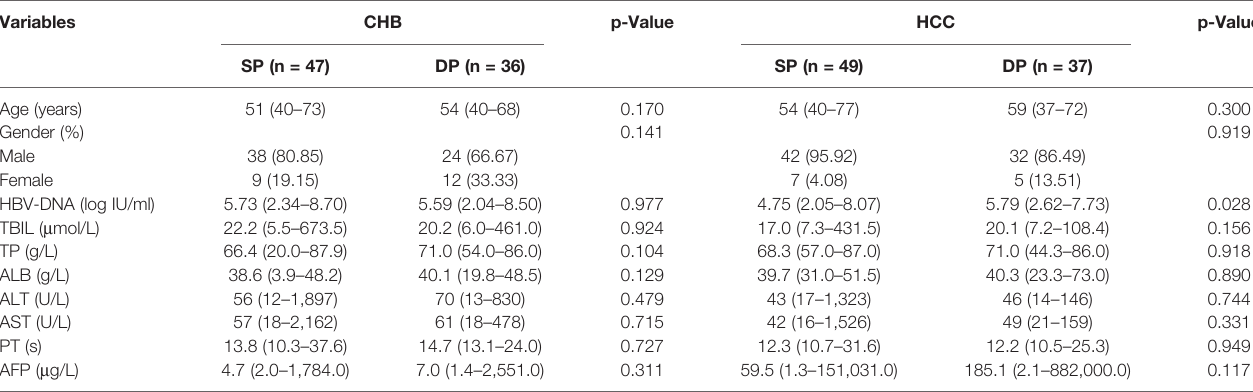
TABLE 1 | Baseline characteristics of CHB and HCC patients in SP and DP